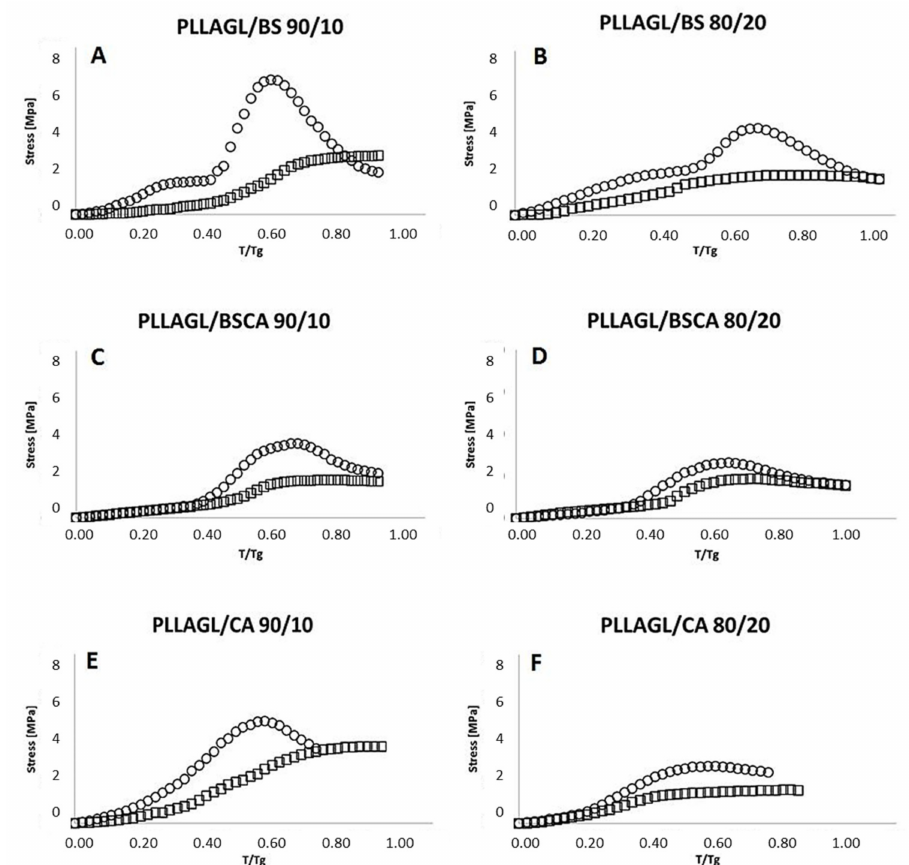
Figure 4. Dependence of the recovery stress, the temperature of recovery, and the temperature of deformation for selected samples (circles-deformation at 37 ◦ C, squares-deformation at T g ) ( A ) PLLAGL / BS 80 / 20 ( B ) PLLAGL / BS 70 / 30 ( C ) PLLAGL / BSCA 80 / 20 ( D ) PLLAGL / BSCA 70 / 30 ( E ) PLLAGL / CA 80 / 20 ( F ) PLLAGL / CA 70 /